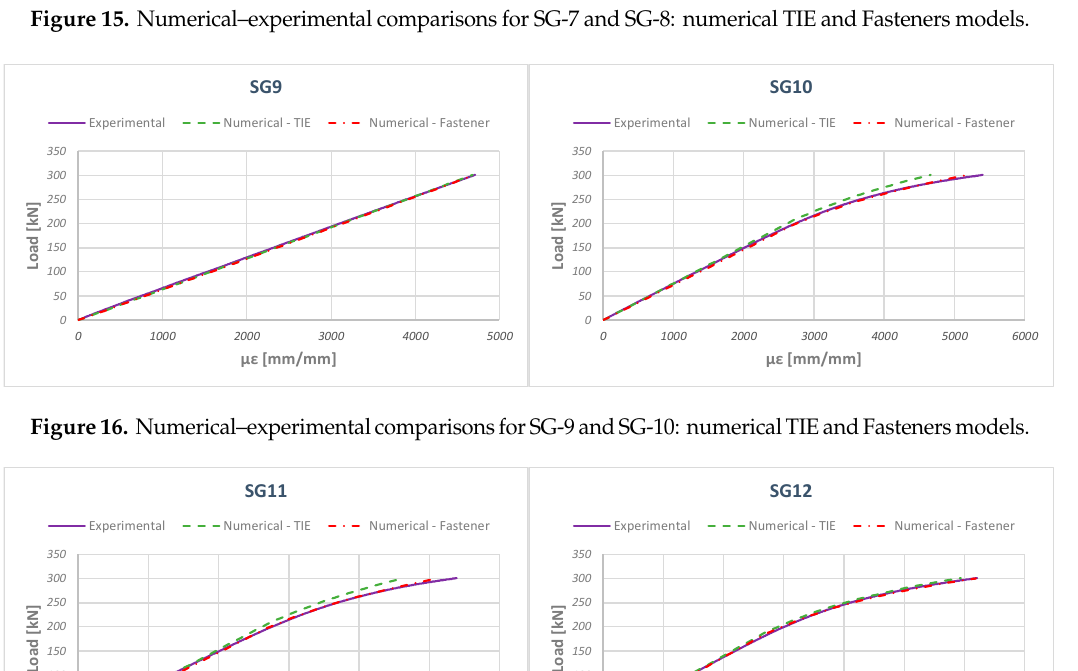
Figure 15. Numerical–experimental comparisons for SG-7 and SG-8: numerical TIE and Fasteners models.